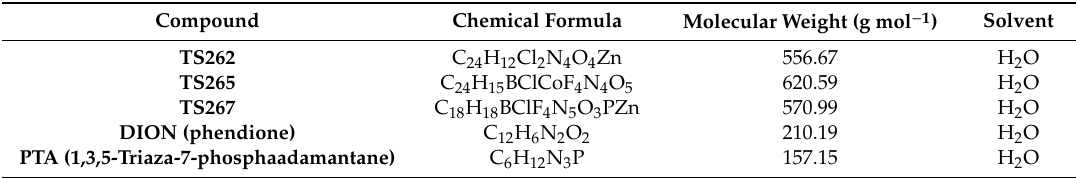
Table 3. Chemical formula, molecular weight, and solvent of the three metallic compounds and their